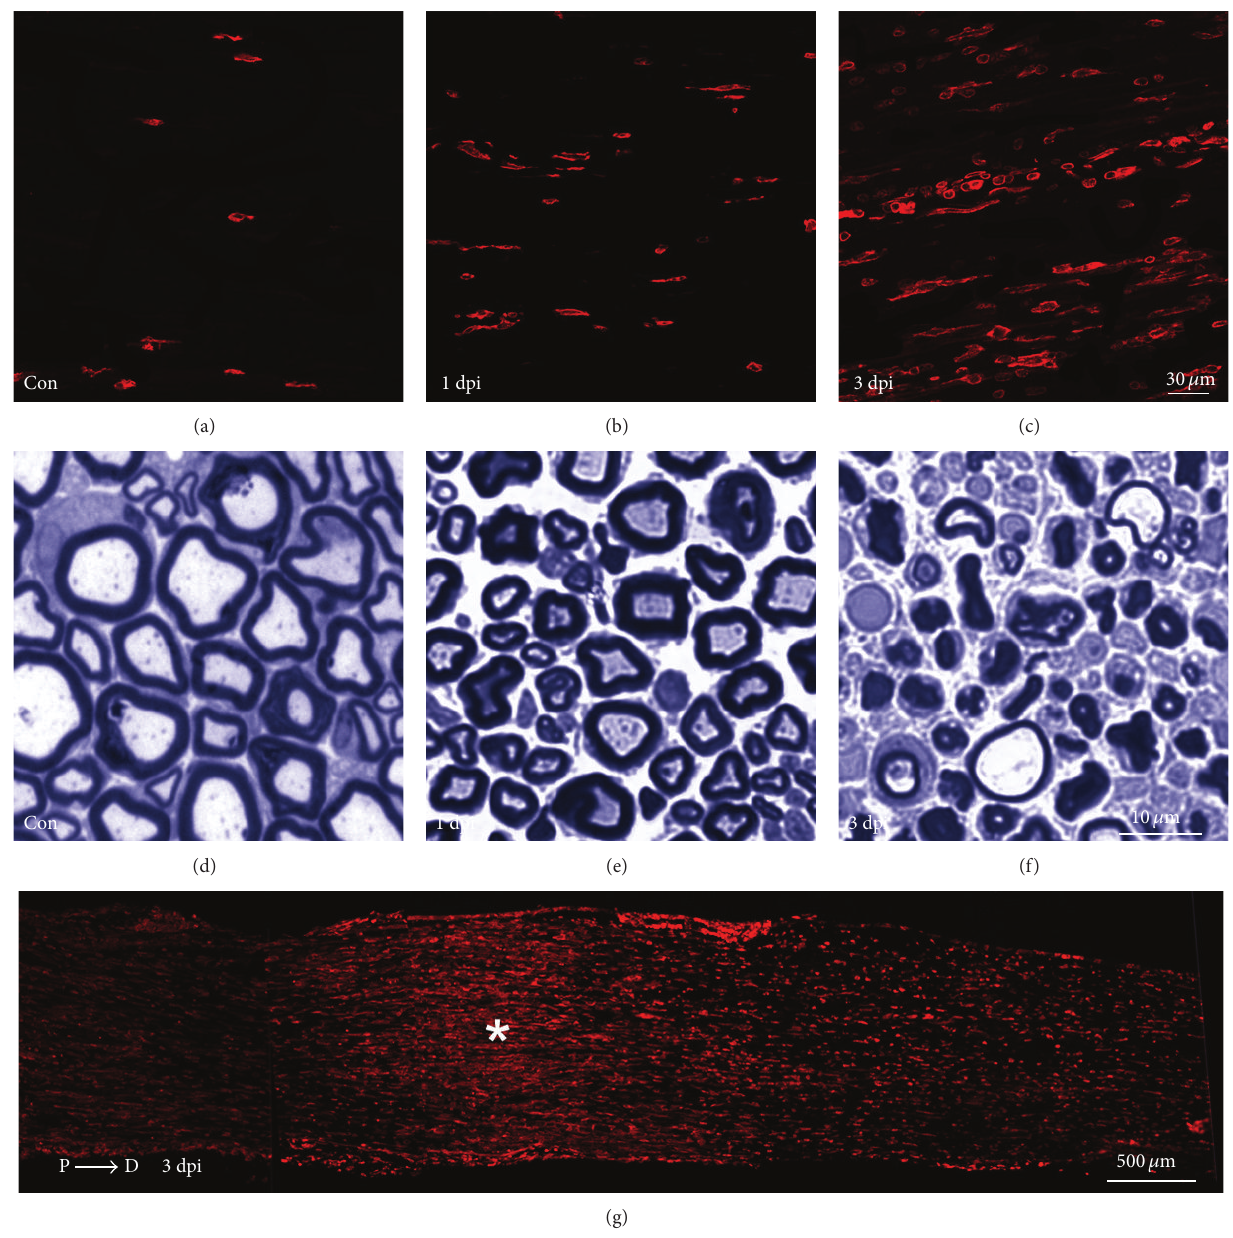
Figure 2: Macrophage accumulation and nerve pathology after PNS trauma. (a), (b), and (c) are representative images of CD11b+ cells (red staining)—which is suggestive of macrophages—in control sciatic nerves, 1 and 3 days post injury (dpi), respectively, at the distal portion of the nerve ( ∼ 2mm from the injury site). Nerve integrity ((d), (e), and (f)) is observed at the distal portion of the nerve ( ∼ 2mm from the injury site) at the same time points mentioned in (a), (b), and (c), respectively. Image (g) is a longitudinal section of injured sciatic nerve at day 3, showing accumulation of CD11b+ cells (red staining) in the entire nerve and showing augmented CD11b+ numbers at the injury site (asterisk) and distal portions of the nerve. Scale bar: (a), (b), and (c) = 30 𝜇 m; (d), (e), and (f) = 10 𝜇 m; (g) = 500 𝜇